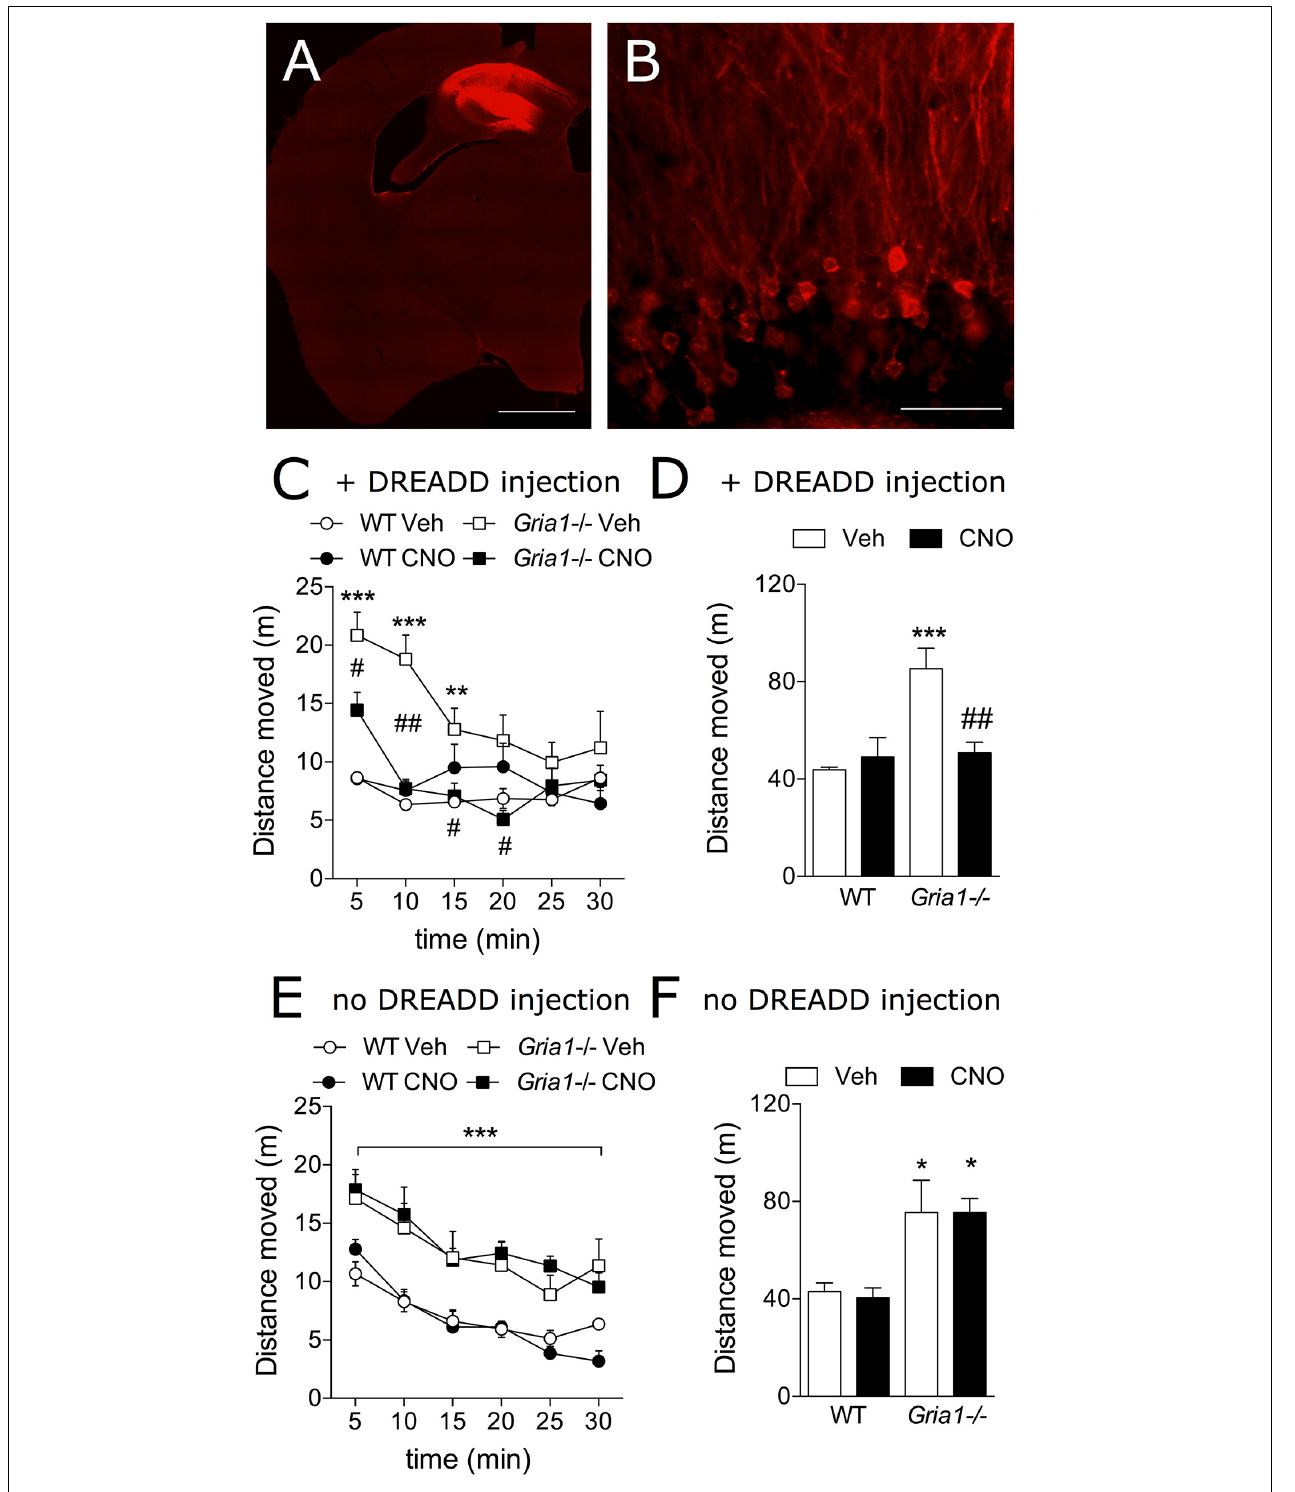
FIGURE 4 | Chemogenetic inhibition of novelty-induced hyperlocomotion in Gria1 − / − mice. (A) Virus injection resulted in hM4Gi-mCherry expression in the dorsal hippocampus. Hb, habenula; fi, fimbria; scale bar: 1 mm. (B) A close-up photograph displaying transduced neurons and neurites in the dentate gyrus. No transduced neurites were observed outside the hippocampus (not shown). Gr, granule cell layer; Mol, molecular layer; scale bar: 50 µ m. (C) Distance traveled in a novel environment in 5-min periods in mice transduced with DREADDs. (D) Total distance traveled during the 30-min trial in mice transduced with